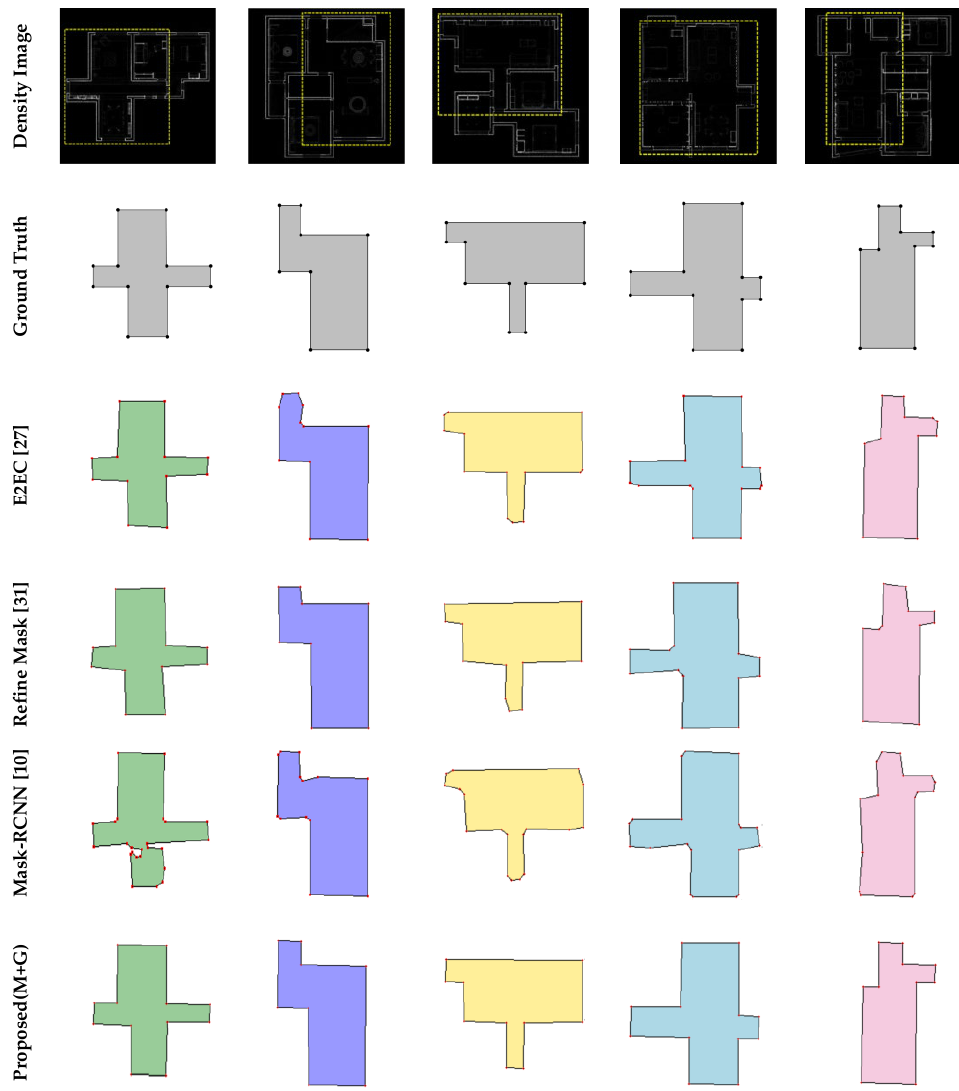
Figure 8. Qualitative comparisons against E2EC, RefineMask, and Mask-RCNN.